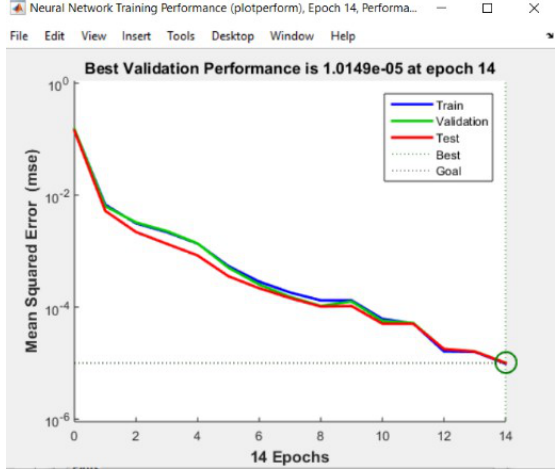
Figure 6. Training process of the Intuitionistic fuzzy deep neural network.